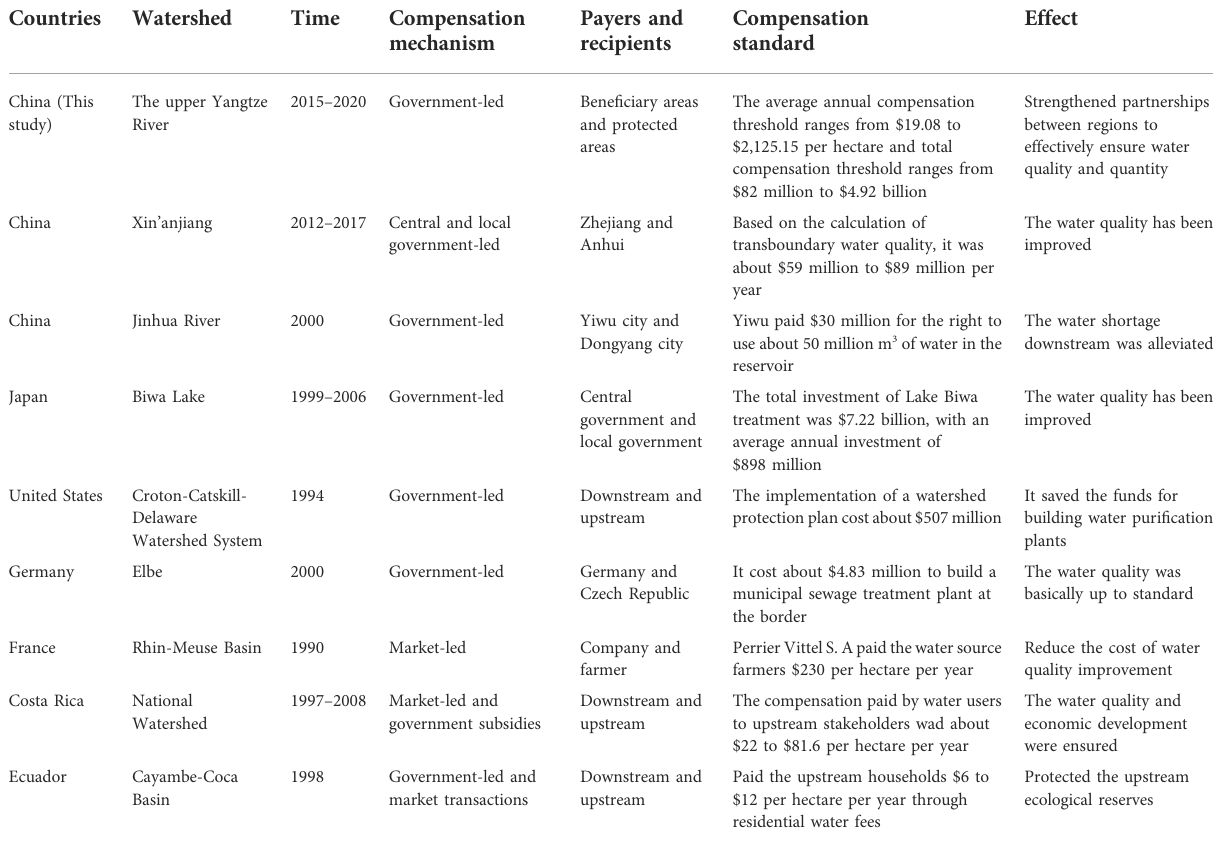
TABLE 2 Research on international watershed ecological